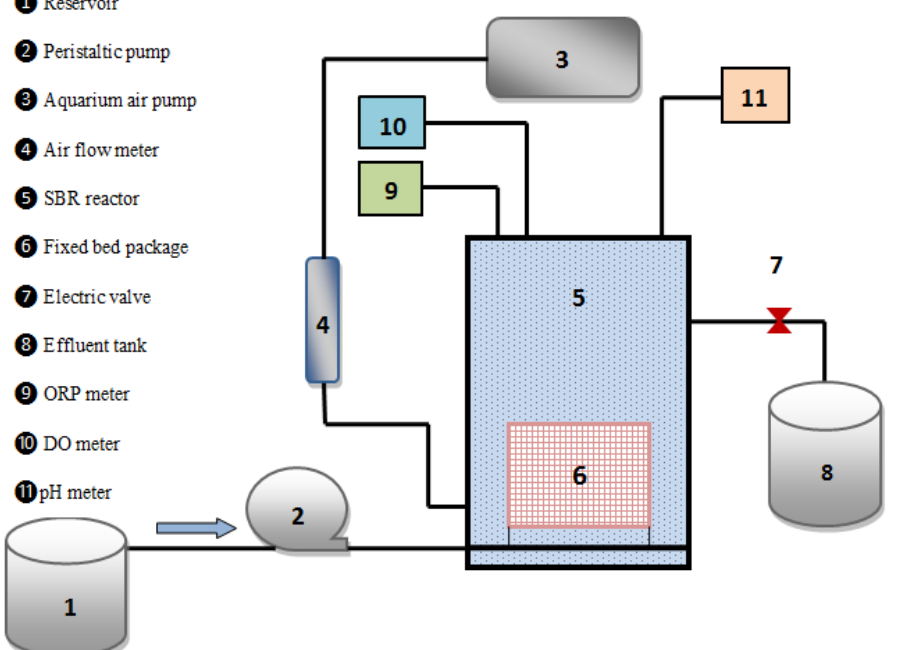
Figure 1. Schematic flow diagram of the experimental